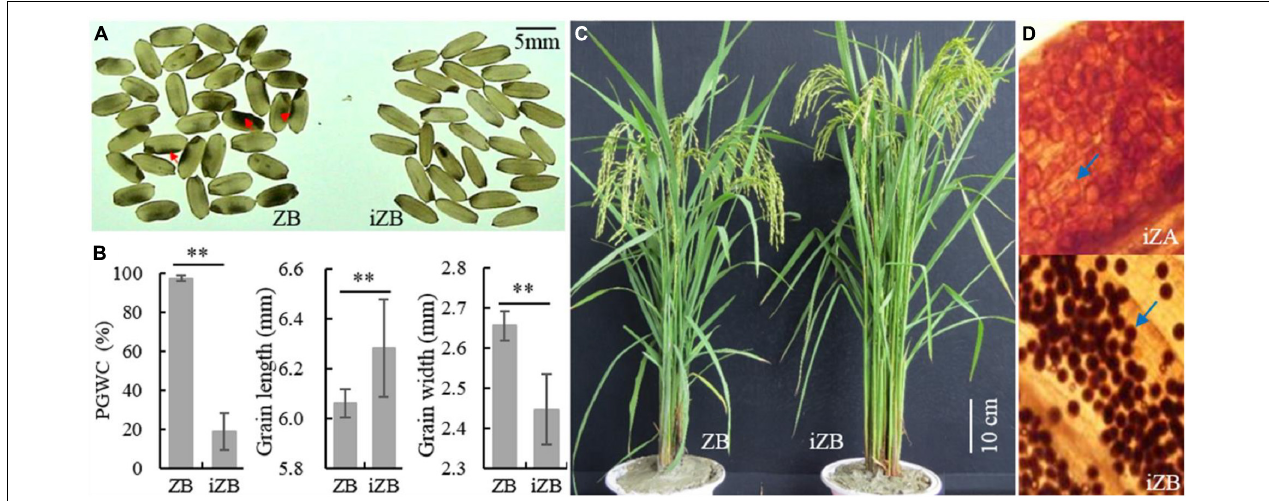
FIGURE 12 | The phenotypes of ZB, iZB, and iZA. (A) Brown rice of ZB and iZB. The red arrows indicate chalkiness. (B) PGWC, GL, and GW traits of ZB and iZB. ∗∗ denotes a difference at a very significant level. (C) Plant morphology of ZB and iZB. (D) Pollen granules dyed by 1% I granules. The pollen granules dyed black are fertile; otherwise, they are sterile. The magnification is 10 ×